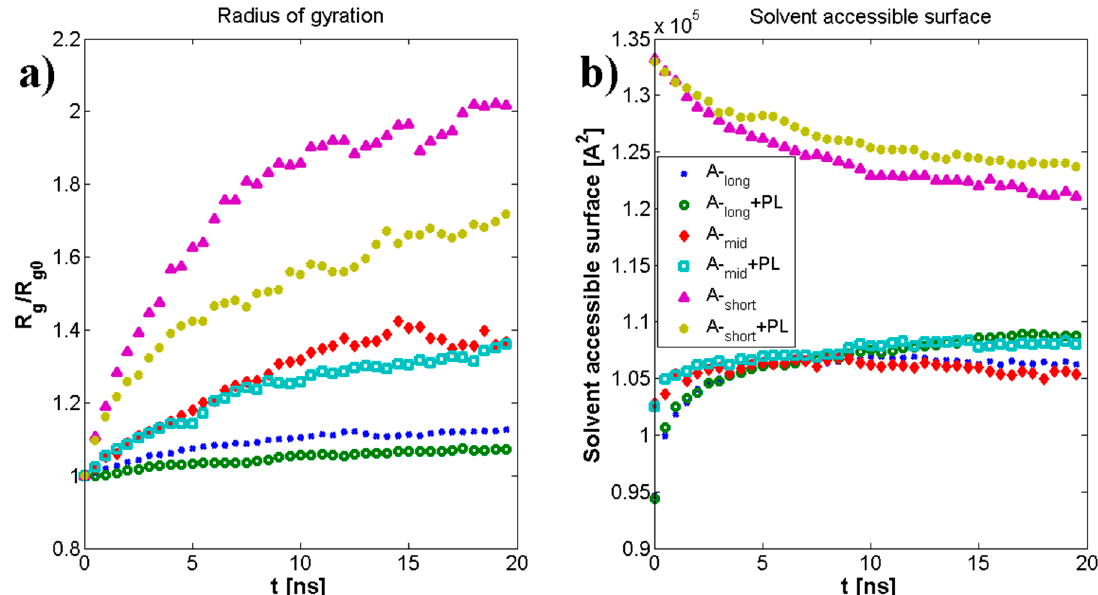
Figure 4. ( a ) The normalized radius of gyration as divided by its initial value and ( b ) solvent-accessible surface of (A-) chain for three molecular masses (MM) with and without phospholipid.